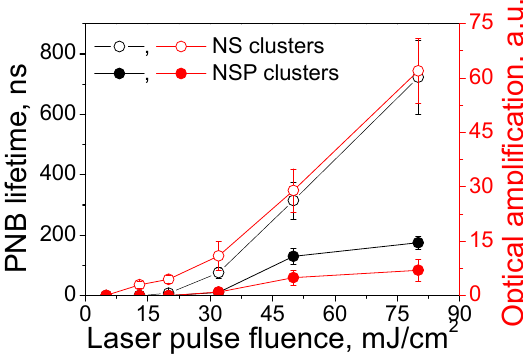
(NS)—hollow dots, clusters of gold spheres (NSP)—solid